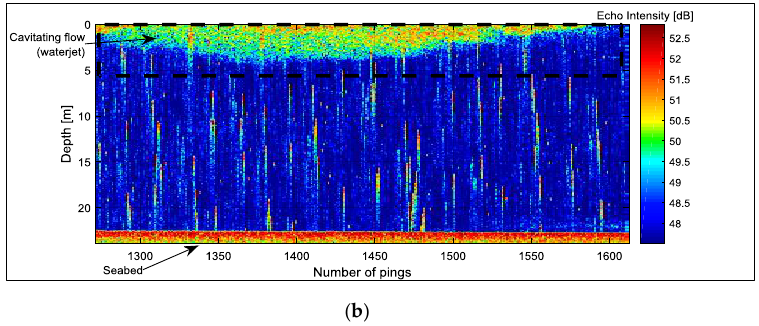
Figure 8. Filtred echograms obtained using DBS data showing cavitating flow from a boat with ( a ) propeller and ( b ) waterjet thruster.